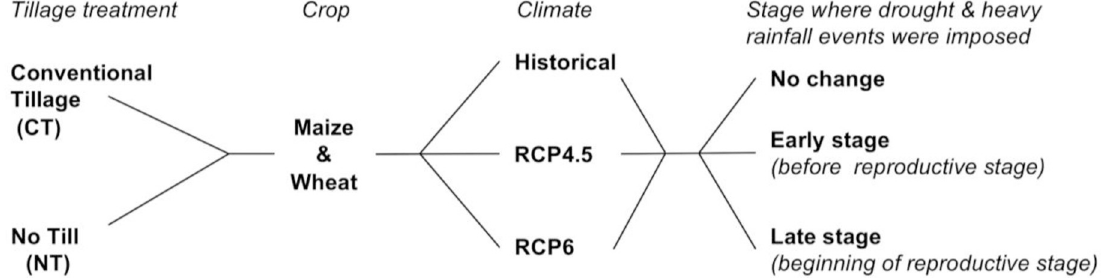
Fig 2. Illustration of the simulation experiments studying the impact of tillage treatments and climate change, considering climate scenarios and precipitation variability at crops’ early and late stages, on the yields of maize and wheat and SOC of the maize-soybean- wheat rotational cropping system.